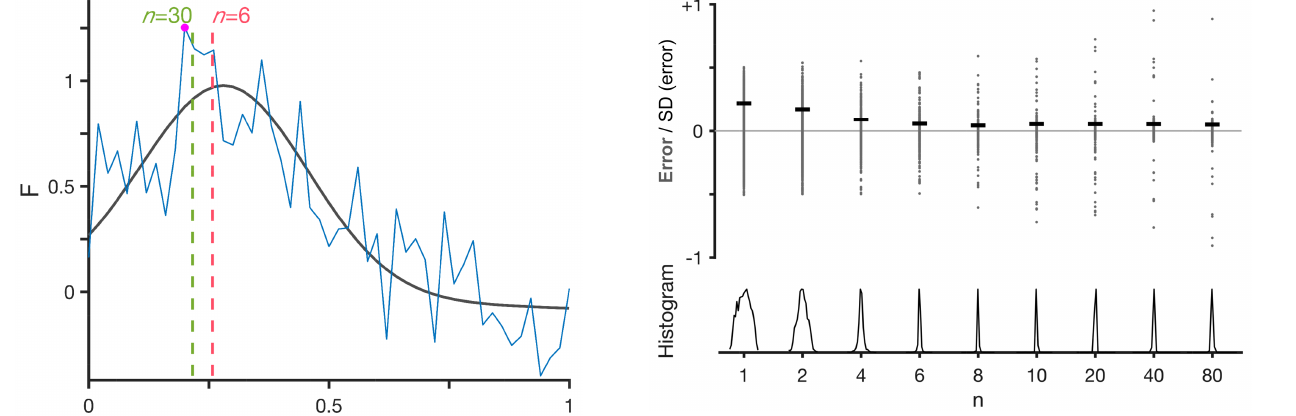
Figure 3. The dependence on n of the error distribution of φ max calculated using Eq. (1) in a representative sample of 100 random- ized skewed Gaussian functions such as the one shown in Fig. 2. The error (gray dots) is defined as the difference between φ max and the latitude of the maximum of the smooth Gaussian function (black line in Fig. 2). SD (error) (standard deviations of the error), horizon- tal lines, and histograms (normalized between 0 and 1) are shown for the error distributions of the sample for each n